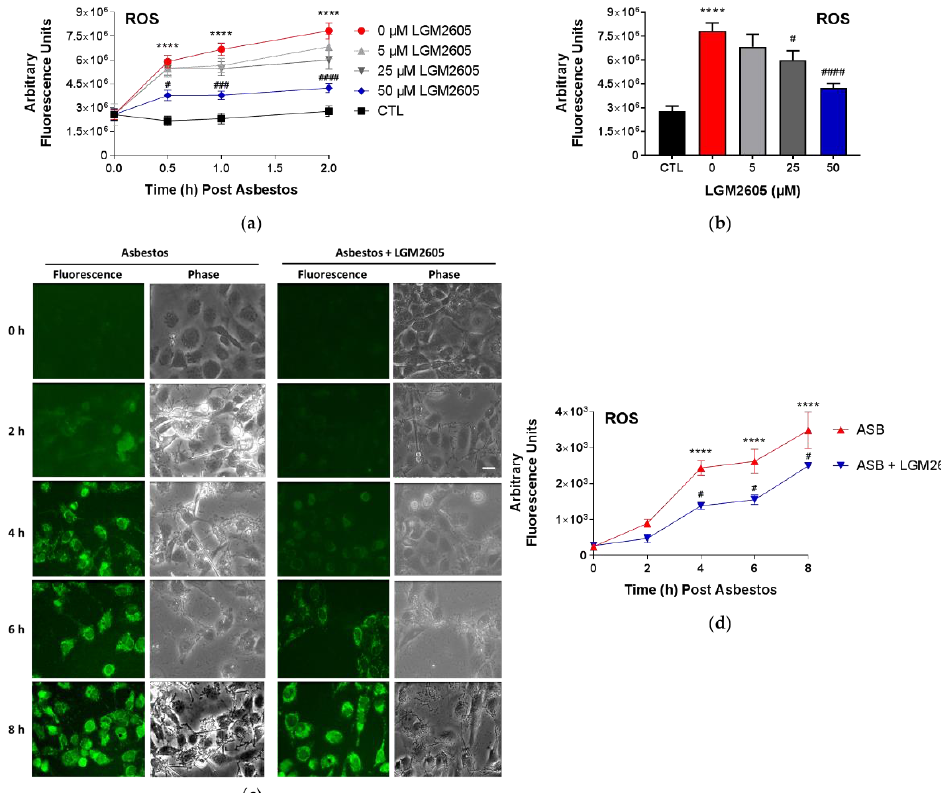
Figure 2. ROS Production Following Asbestos Exposure. Human pleural mesothelial cells were plated in a 96-well plate (2 × 10 4 cells/well) and exposed to LGM2605 4 h prior to exposure to sterile crocidolite asbestos fibers (20 µg/cm 2 ). ROS generation was determined by DCF fluorescence. The dose–response relationship between asbestos-induced ROS generation and various concentrations of LGM2605 treatment (0, 5, 25, and 50 µM) at 0, 0.5, and 2 h post asbestos exposure ( a ). Data are also presented separately for the 2 h time point ( b ). Asbestos-induced ROS generation in mesothelial cells treated with 50 µM LGM2605 was determined through 8 h post asbestos exposure ( c ). Human pleural mesothelial cells were exposed to asbestos and labeled with the oxidative stress sensitive dye, CellROX ® Green Reagent. The intensity of the cells in each field ( scale bar = 15 μm ) was integrated to obtain the total fluorescence intensity of a particular field ( d ). Samples were run undiluted in triplicate and data are presented as mean ± SEM. * indicates a statistically significant difference ( p < 0.05) from baseline (time 0 h) for cells exposed to asbestos (**** p < 0.0001). # indicates a statistically significant difference ( p < 0.05) between ASB and ASB + LGM2605 treated cells (# p < 0.05, ### p < 0.001, #### p < 0.0001).